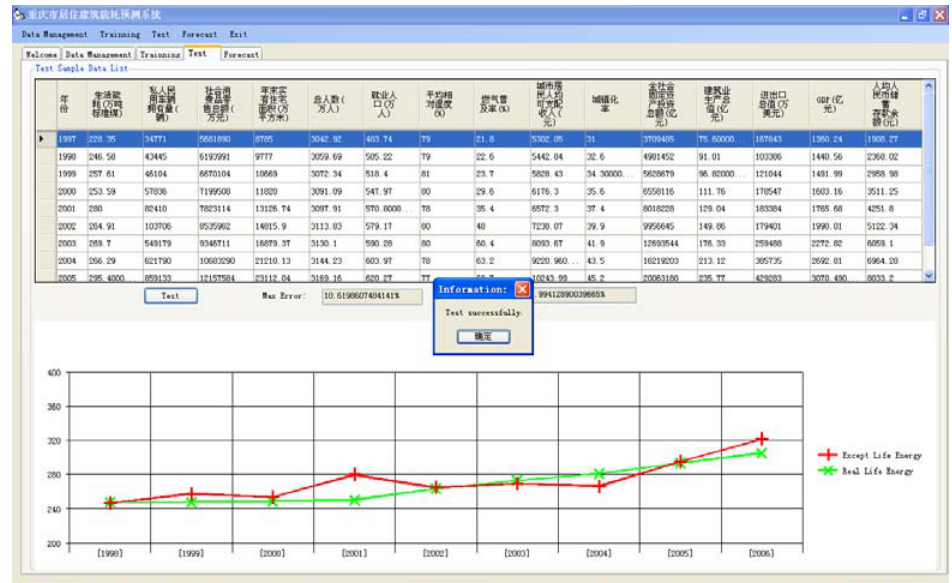
Figure 5. Data test.